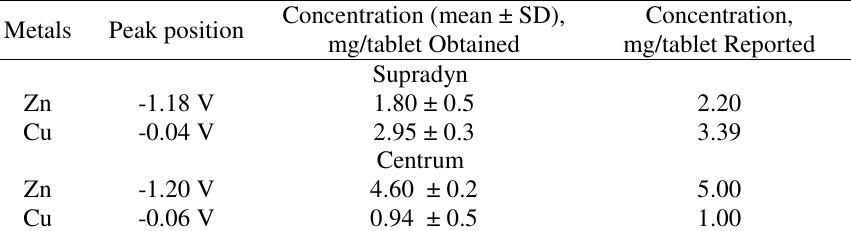
Table 1. Concentration of metals present in multivitamin